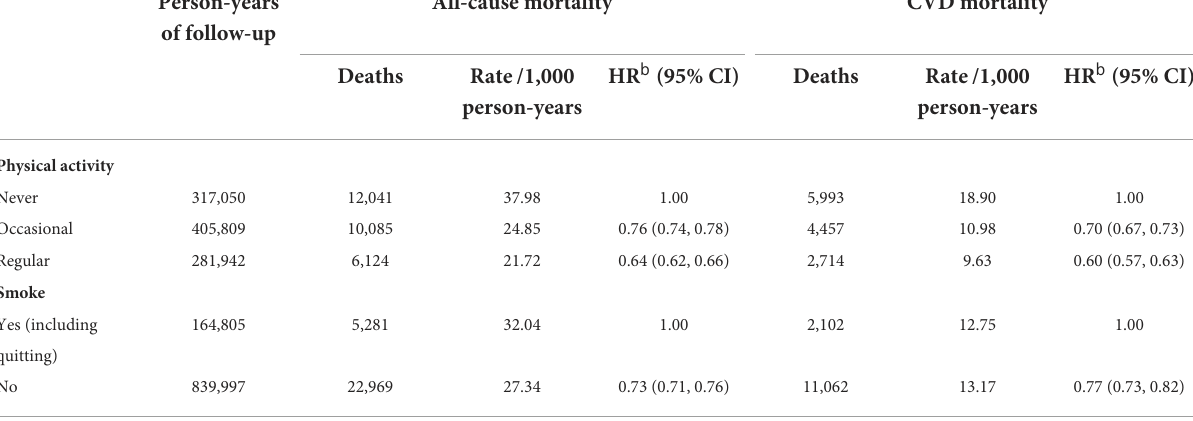
TABLE 2 The hazard ratios for the independent associations of smoking and physical activity on mortality risk a . Person-years